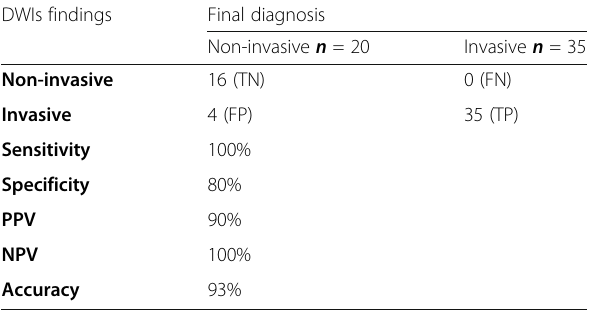
Table 5 Diagnostic performance of DWI in assessment of degree of muscle invasion of urinary bladder carcinoma